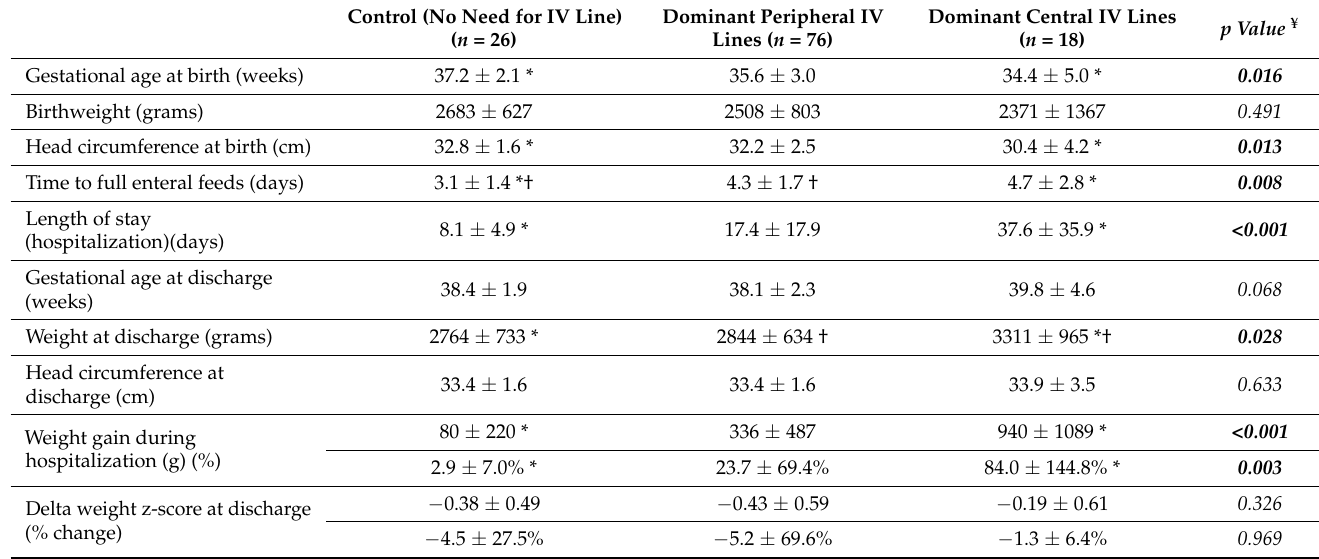
Table 3. Analysis of clinical characteristics and outcomes by patients’ dominant IV line ( n =